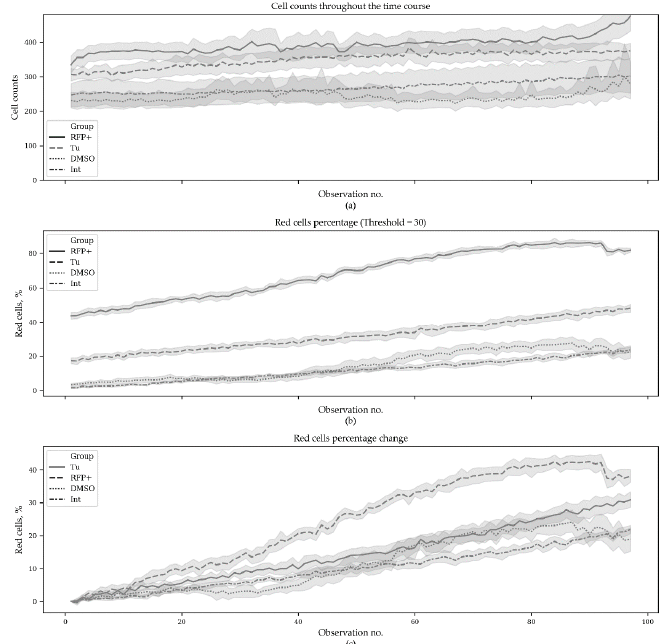
Figure 2. Cell counts and percentage of the red cells during the ER stress time course. In total, 3880 microscopic images were analyzed (970 images per group with 10 fields of view per time point). Tu— experimental group, where ER stress was induced with tunicamycin (10 µg/ml); TagRFP+—positive control group with constantly expressed TagRFP; DMSO—negative control group of transfected cells with DMSO added (tunicamycin solvent); Int (intact)—negative control group of transfected cells. ( a ) CellCountCV was used to estimate the cell counts; ( b ) red cells were counted at red intensity threshold set to 30 (out of 255) and the percentage of red cells was calculated; ( c ) the initial red cells percentage was subtracted from all subsequent values for each field of view. The horizontal axes correspond to observation number. The original data can be found in Table S1. Figure 3 demonstrates the same results but only for the starting and the ending time points. Figure 3. Cell counts ( a ), red cell counts ( b ) and red cells percentage ( c ) in the beginning and at the end of ER stress time course. Tu—experimental group where ER stress was induced with tunicamycin (10 µg/ml); TagRFP+—positive control group with constantly expressed TagRFP; DMSO—negative control group of transfected cells with DMSO added (tunicamycin solvent); Int (intact)—negative control group of transfected cells (N = 10). Statistical analysis was performed with the non-parametric Mann–Whitney test and Bonferroni p-value adjustment for multiple comparisons. Since the initial percentages of red cells were significantly different between the groups (excepting the negative controls), the initial values were subtracted from the subsequent ones. It was found that at the end of experiment, the red cell